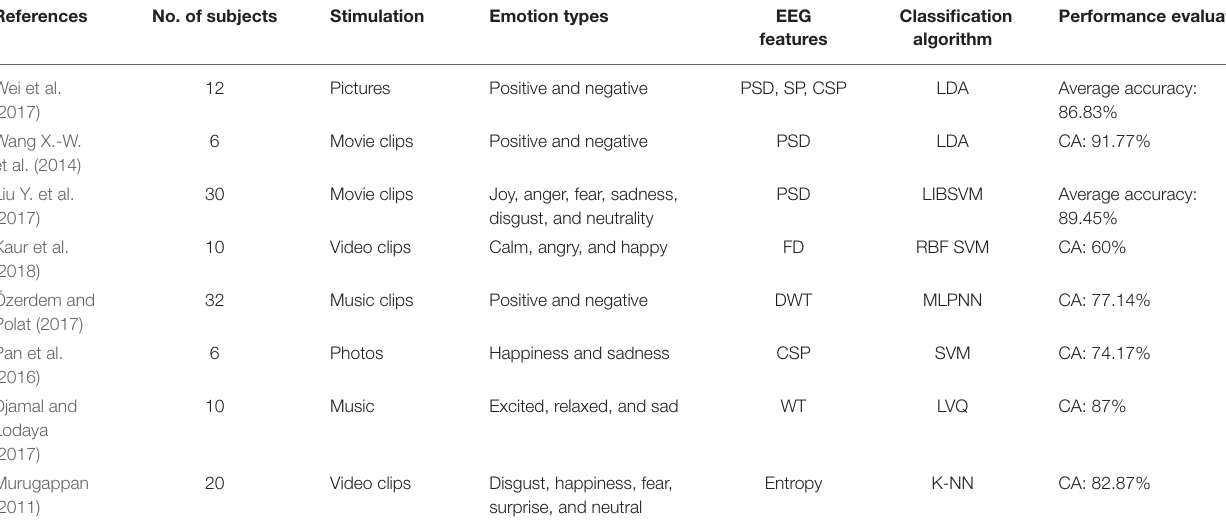
TABLE 7 | Summary of EEG-based BCI emotion recognition studies.